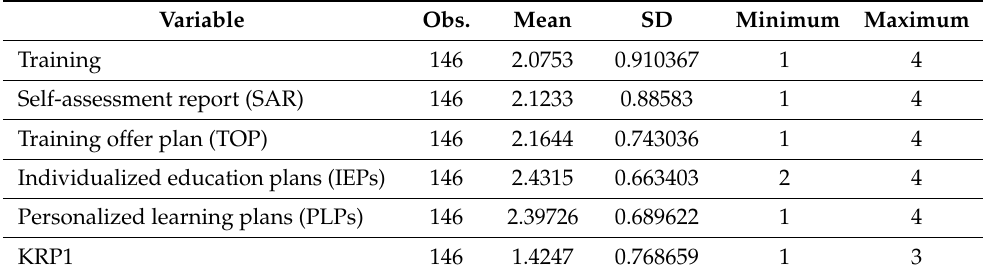
Table 2. Descriptive statistics.